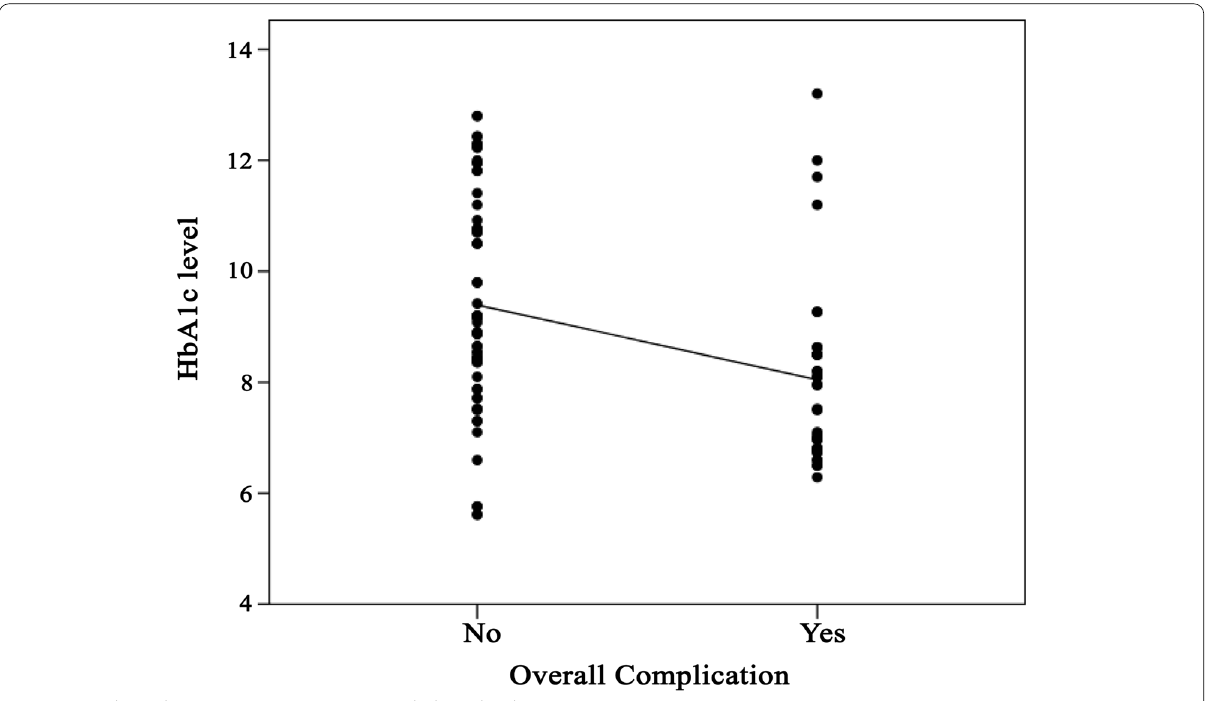
Fig. 2 Correlation between MACE occurrence and HbA1c level ( n